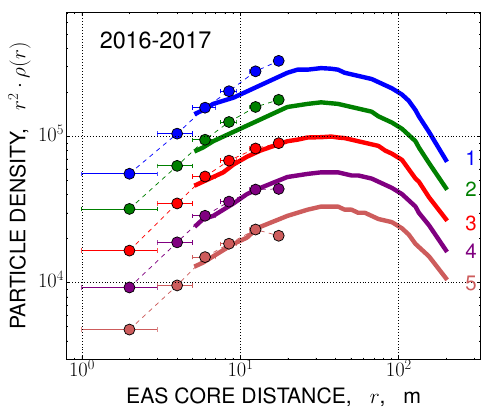
Figure 1. Lateral distribution of shower particles density in EAS with di ff erent sizes N e according to the present time measure- ments (circles) in comparison with analogous data of former Tien Shan experiments (continuous lines). Mutual correspon- dence between the numbers of plotted distributions and the range of EAS sizes is the following: N e 7 . 3 10 6 (1) , N e 4 . 1 10 6 (2) , (cid:27) · (cid:27) · N e 2 . 3 10 6 (3) , N e 1 . 3 10 6 (4) , and N e 7 . 3 10 5 (5) (cid:27) · (cid:27) · (cid:27) ·